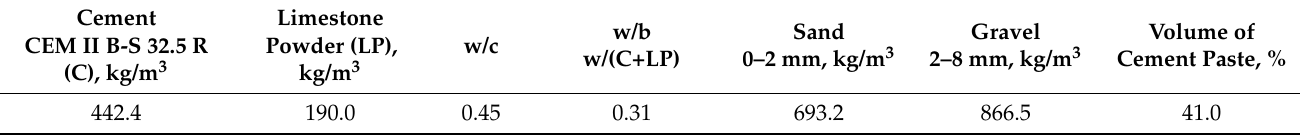
Table 1. Concrete